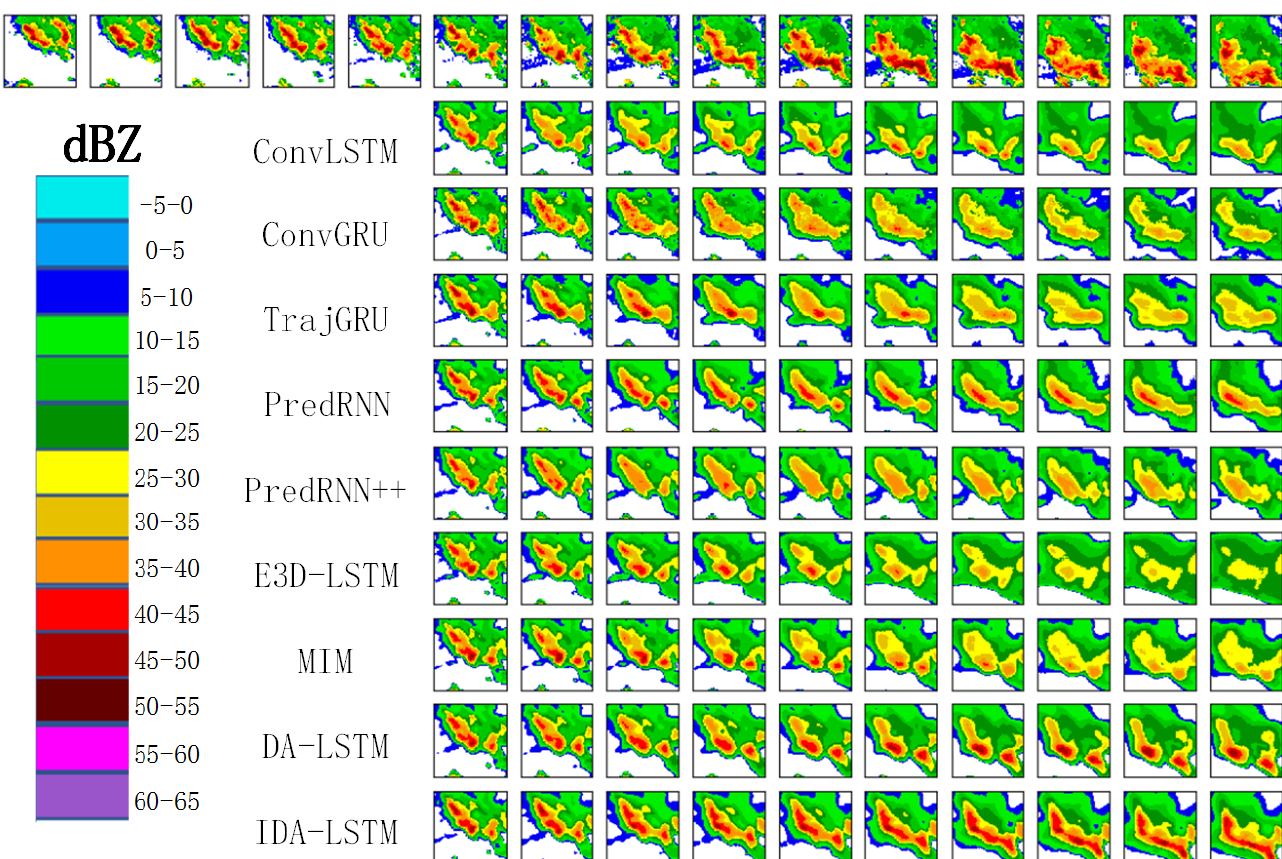
Figure 11. The prediction results of all methods on an example from the CIKM AnalytiCup 2017 competition. The first five images in the first row are the input, and the remainders denote the ground-truth output. Other rows are the prediction of various